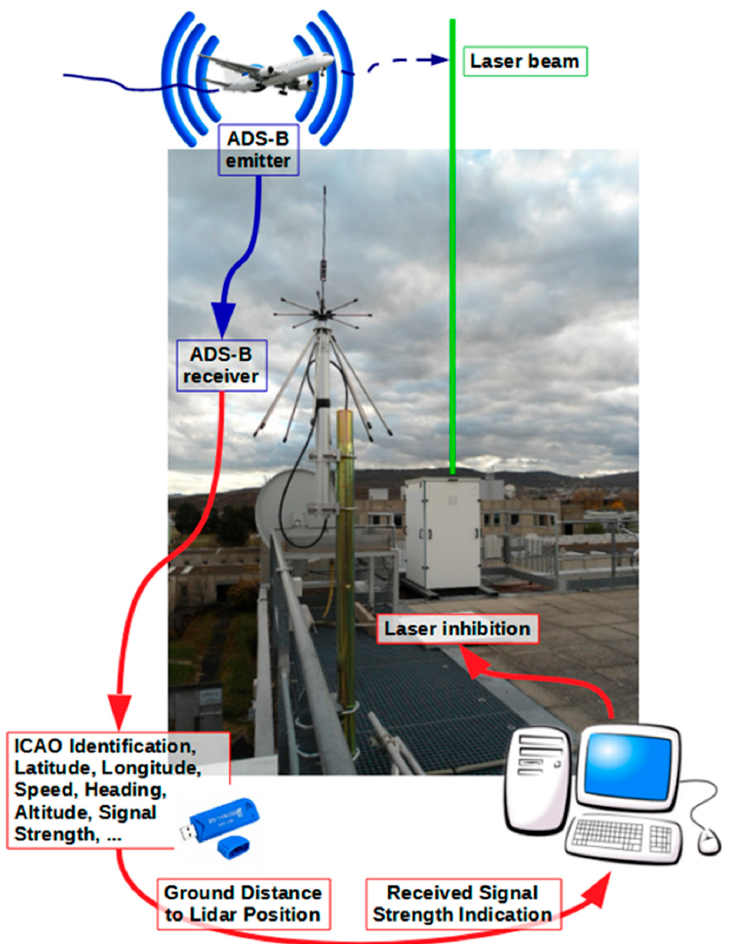
Figure 1. Overview of the air-safety system based on a picture of the outdoor OPGC platform.